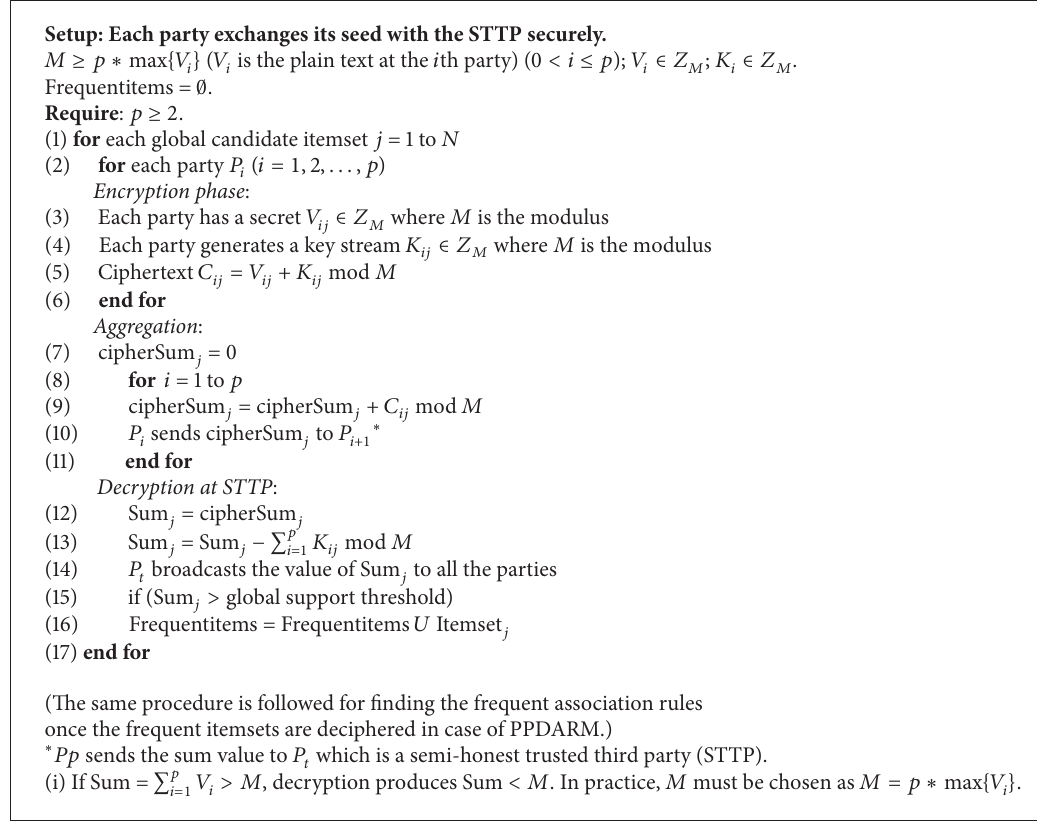
Algorithm 2: Proposed algorithm for secure sum in PPDFIM using symmetric keys. Table 1: Comparative analysis for schemes to evaluate secure sum for